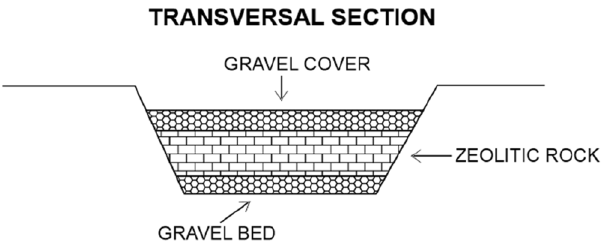
Figure 5. Schematic transversal section of the pilot plant built up at San Giustino